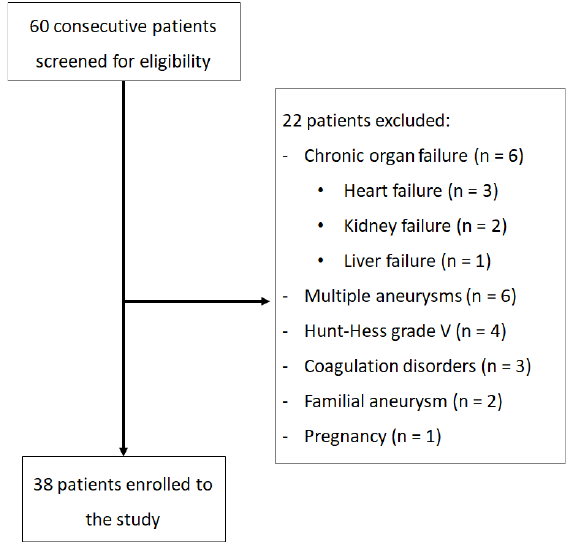
Figure 1. Flowchart presenting the enrollment of the patients. The clinical and laboratory data for all included patients are summarized in Table 2. Complete clinical data.